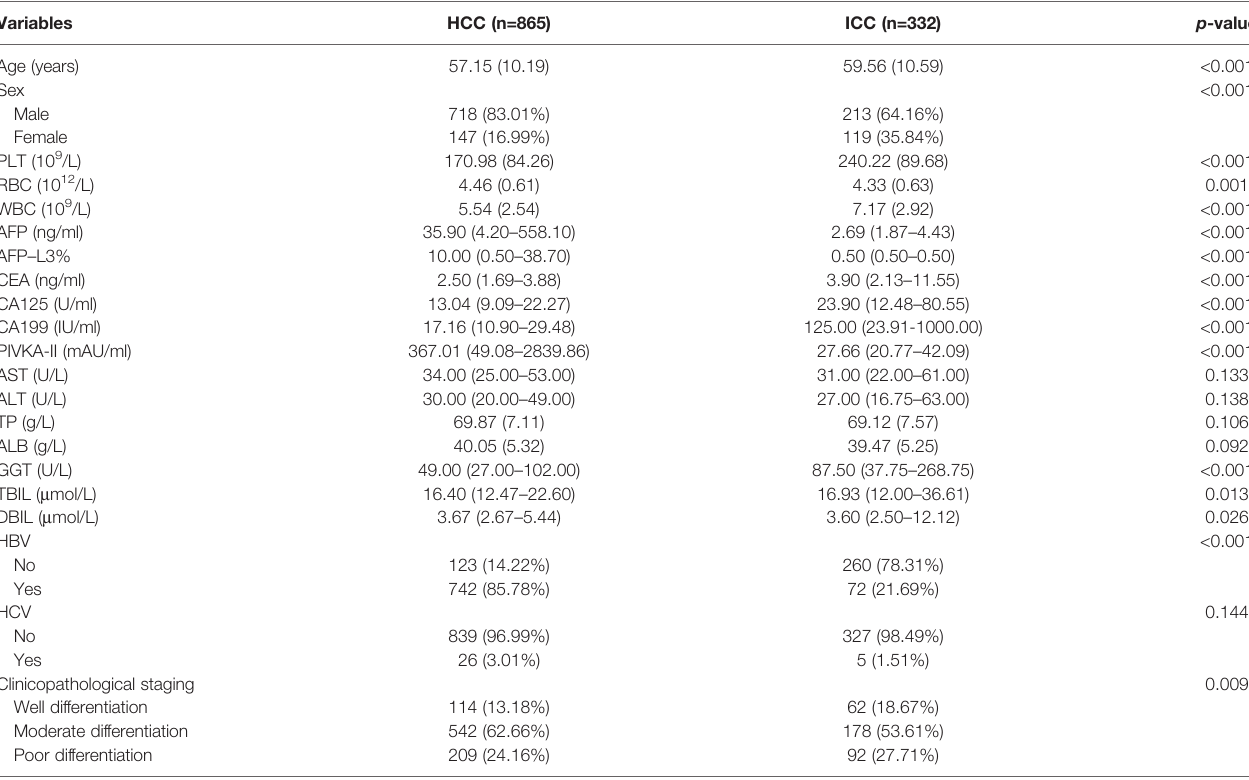
TABLE 2 | Demographic information and clinicopathological characteristics of the training